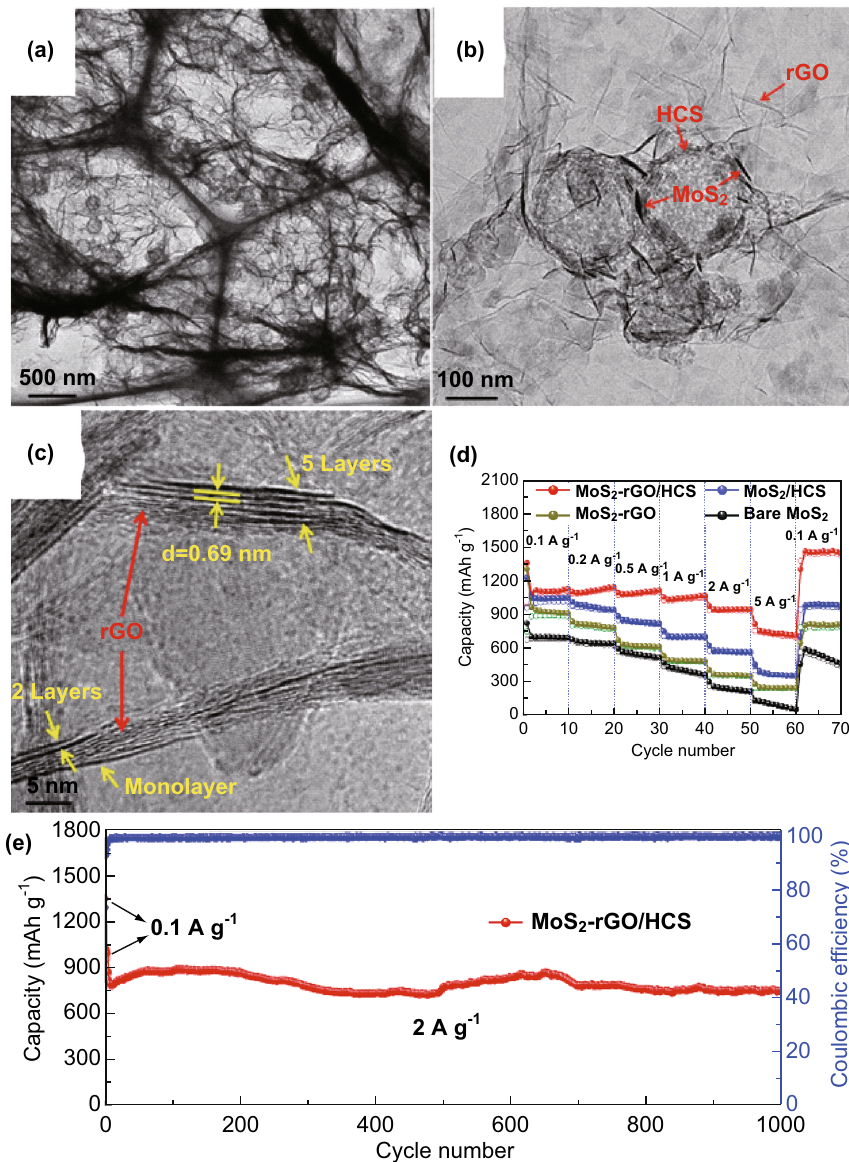
Fig. 14 3D architectures based on 2D MoS 2 /rGO nanoflakes for SIBs. a, b TEM images, c HRTEM image of the MoS 2 -rGO/hollow carbon sphere composite. d Rate capability of MoS 2 -rGO/hollow carbon spheres, MoS 2 /hollow carbon spheres, MoS 2 -rGO, and bare MoS 2 . e Cycling performance and Coulombic efficiency of MoS 2 -rGO/hollow carbon spheres for 1000 cycles at the current density of 2 A g - 1 . Reproduced